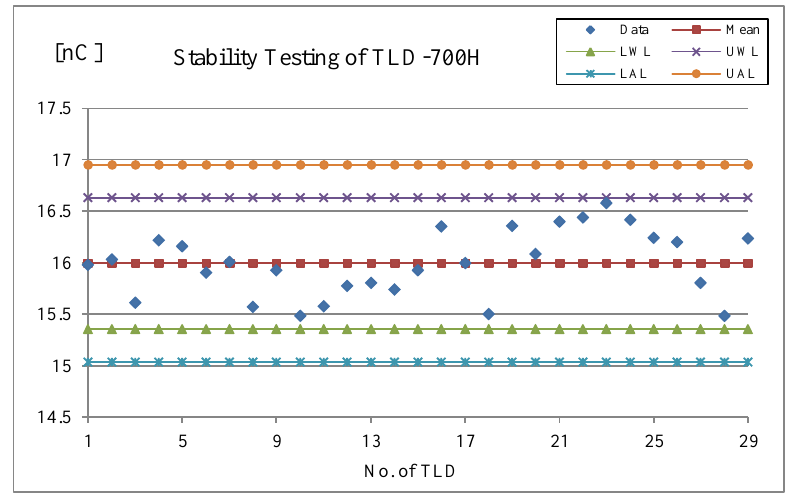
Figure 6b. Stability testing of TLD-700H by using 90 Sr (2)